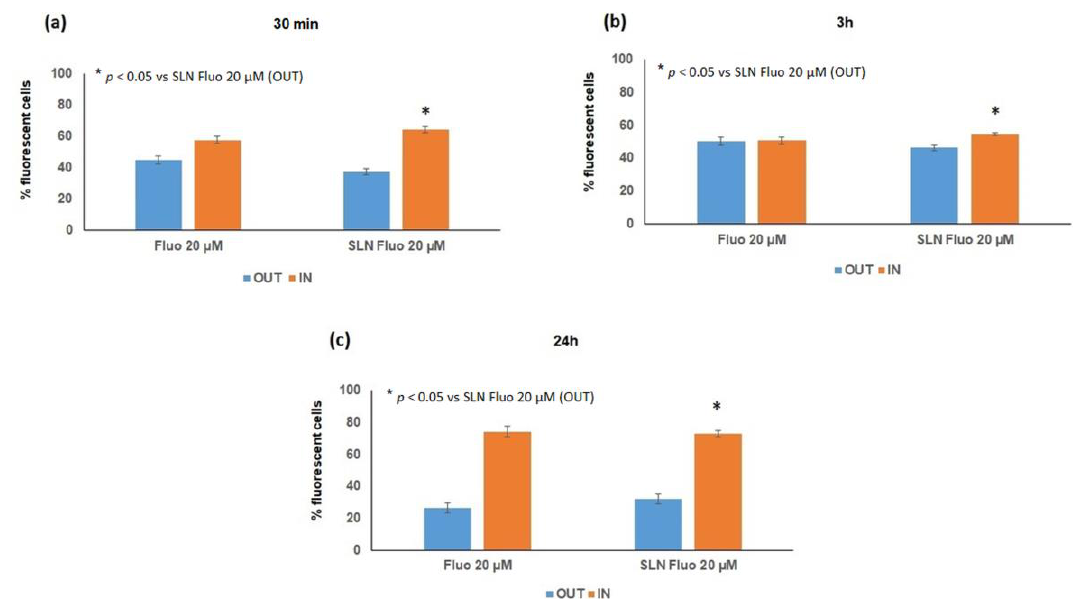
Figure 11. Effects of in vitro cellular uptake on Caco-2 cells at 30 min ( a ), 3 h ( b ), and 24 h ( c ).